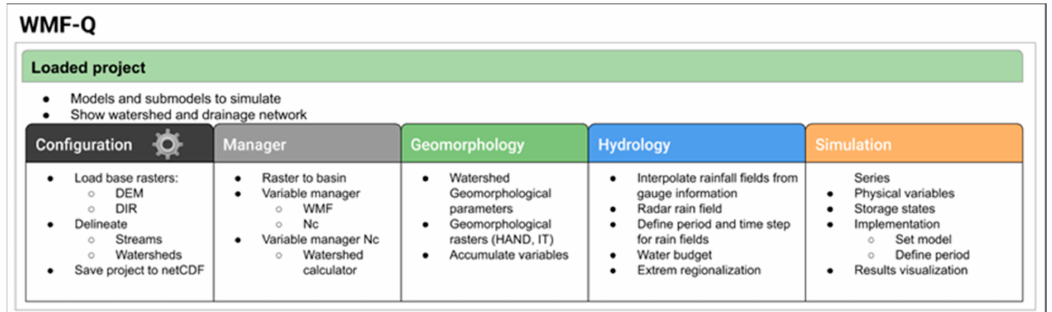
Figure 5. Description of the WMF-Q structure and its